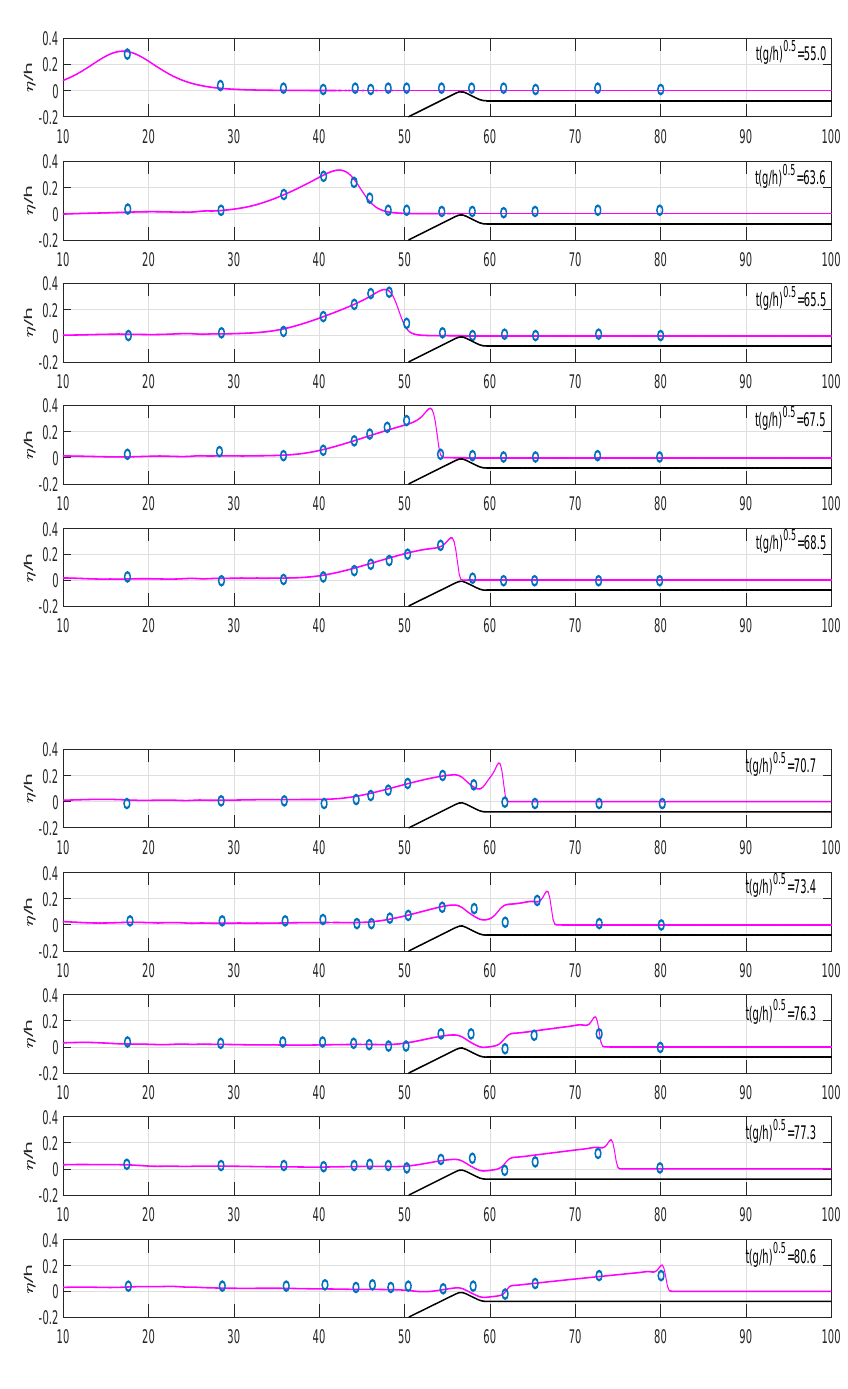
Figure 11. A solitary wave transformation over a submerged reef crest with height 0.2, A / h = 0.3 and 1/12 slope. Solid line: numerical results, circles: experimental